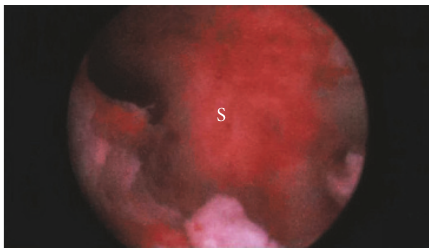
Figure 9: Uterine septum (S). Otherwise normal uterine